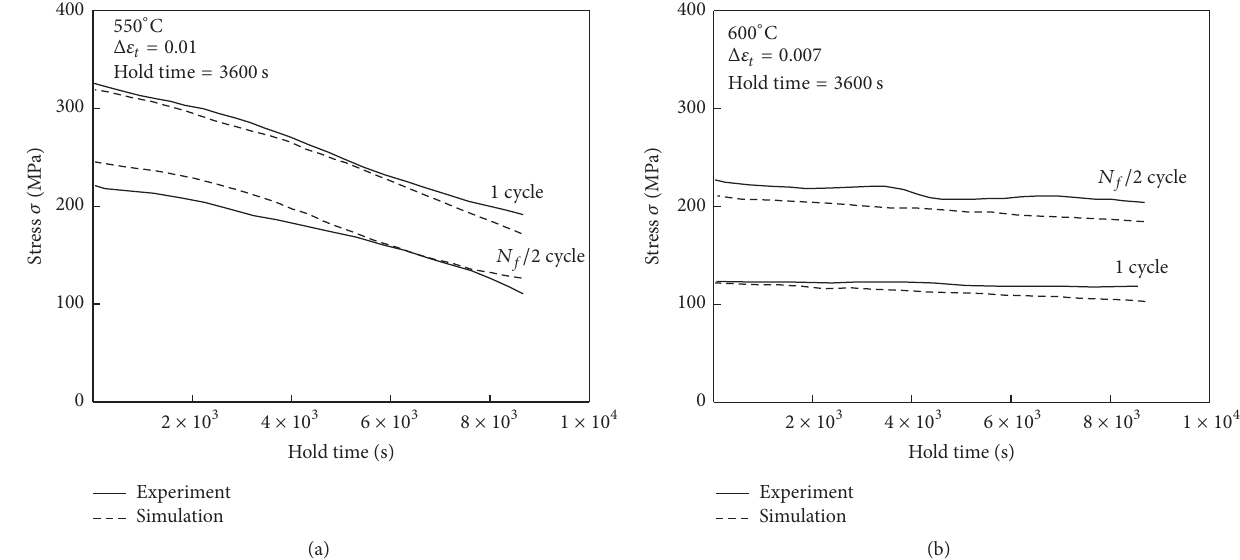
Figure 7: Stress relaxation curves at first and half-life cycles for (a) a modified 9Cr-1Mo steel and (b) a 316 stainless